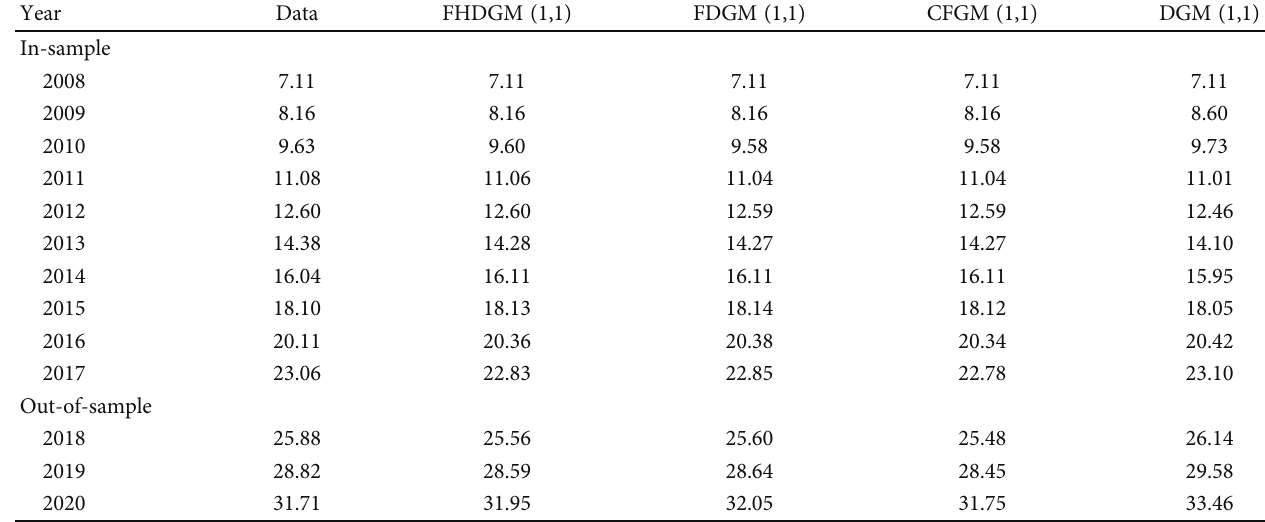
Table 15: Fitted and predicted values of four models related to global renewable energy consumption.